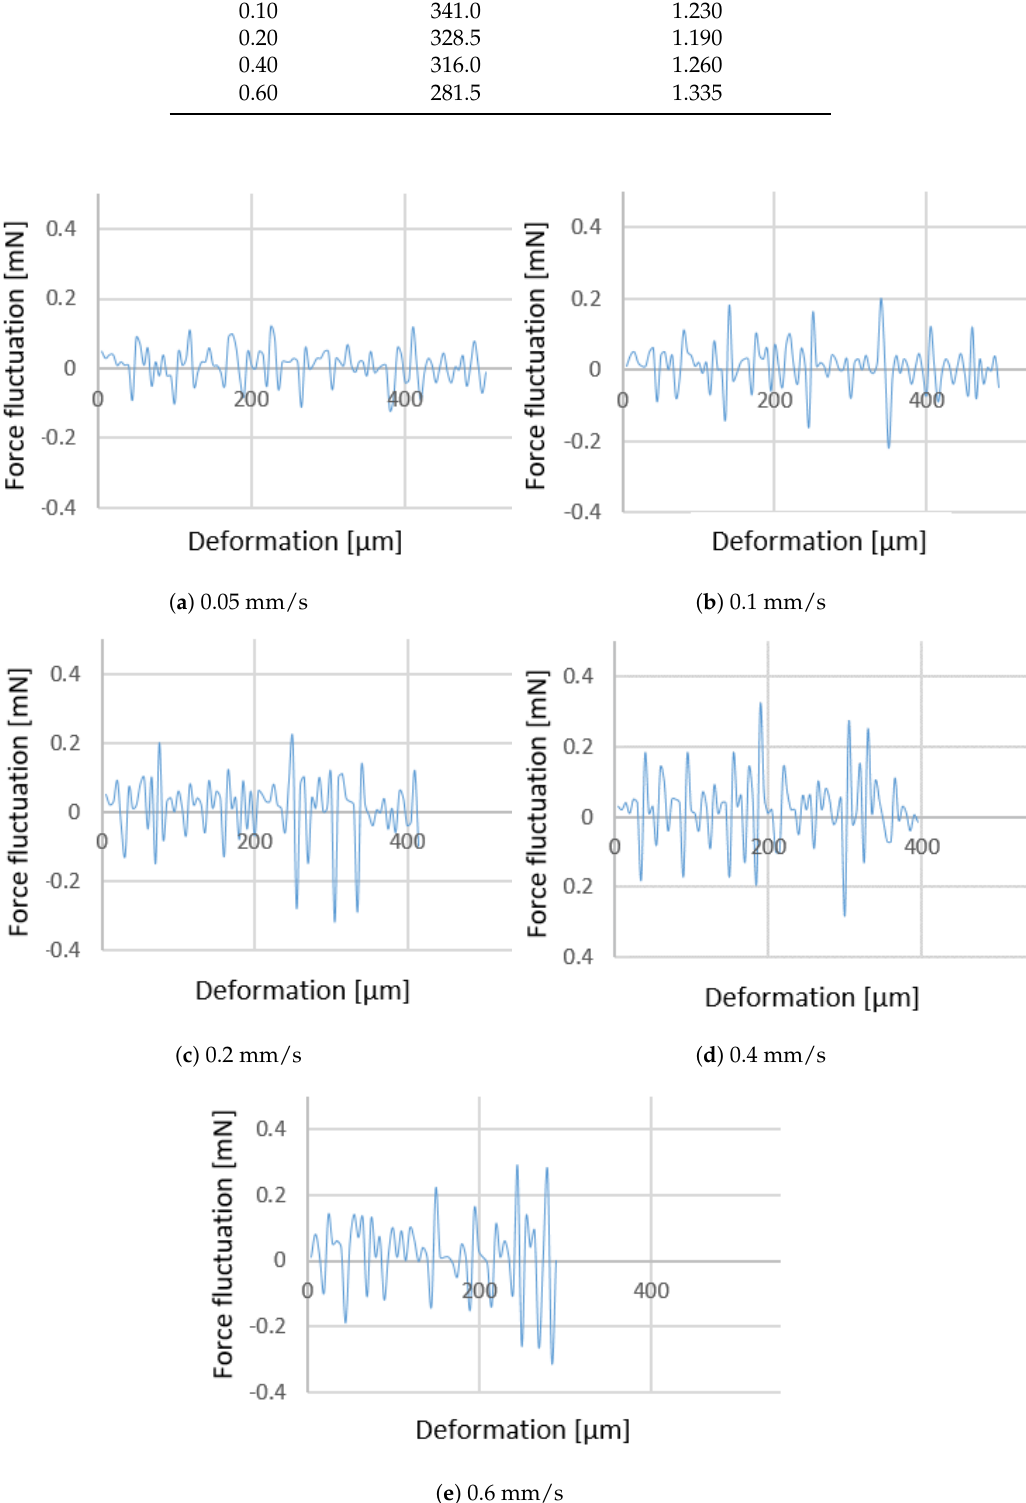
Figure 8. Force fluctuation obtained for varius injection